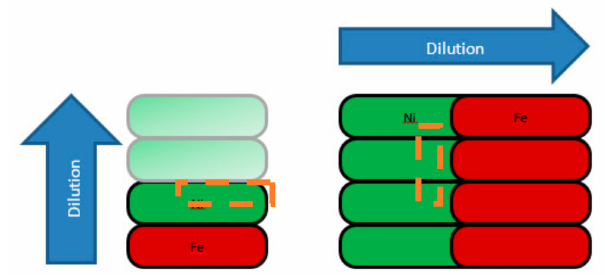
Figure 10. Illustration of the dilution processes (box: schematic specimen